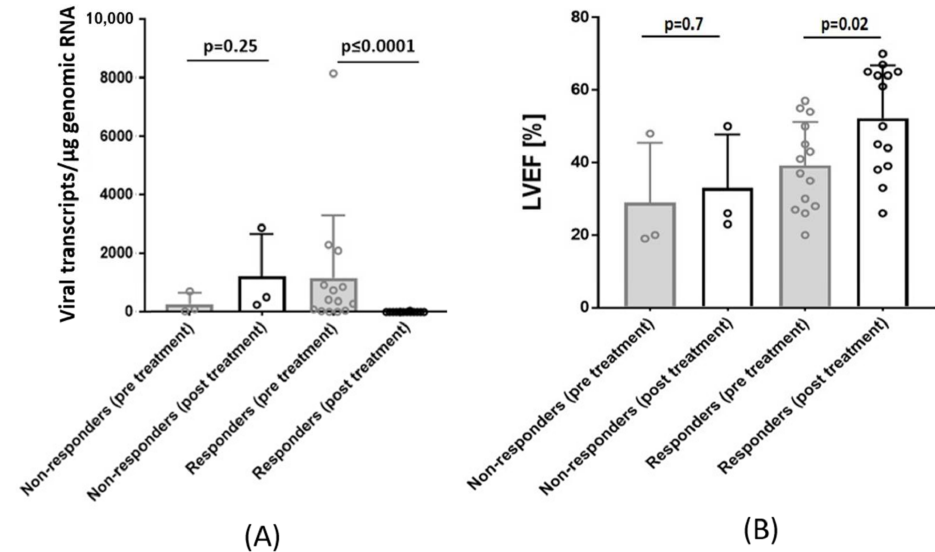
Figure 7. ( A ) Transcriptionally active cardiotropic B19V infection patients treated antivirally with the nucleoside analog telbivudine (LTD). Bar height indicates the mean value ± SD expression rate of viral transcripts/ µ g RNA in non-responders’ ( n = 3) and responders’ group ( n = 14) pre (baseline) and post (follow-up) LTD-treatment. Whereas responders significantly reduce viral replica- tion intermediates upon treatment, non-responders show a non-significant increase of viral RNA. ( B ) LVEF of non-responders and responders pre and post-treatment with LTD. Bar height indicates LVEF (%) in non-responders’ and responders’ groups pre and post LTD-treatment. LVEF improve- ment was significantly improved in patients who reduced or lost the replicative viral intermediates (positive B19V RNA). LVEF is given as mean value and error bars represent SD [19].